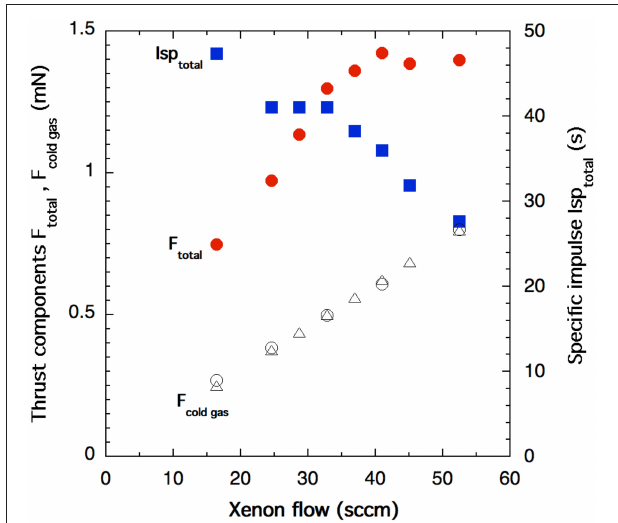
FIGURE 4 | Total F total (filled red circles) and cold gas F cold gas (open circles) thrust components and total specific impulse I sp total (filled blue squares) measured vs. xenon gas flow rate for constant rf power of 32 W and a driving frequency of 13.78 MHz; cold gas specific impulse I sp cold gas is constant at ∼ 16 s; F cold gas (open triangles) is calculated using Equation (3). The error bar on thrust components is ± 0.25